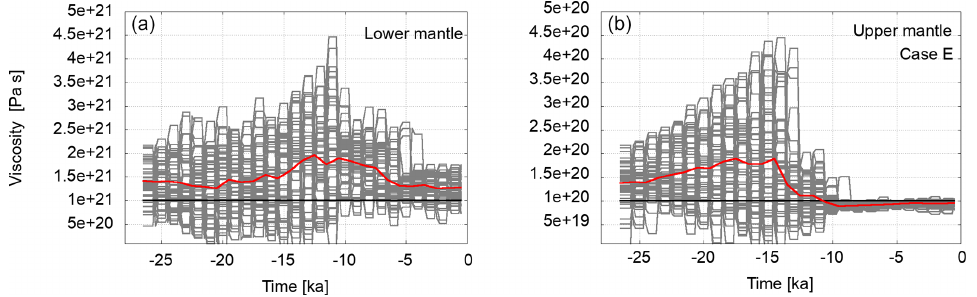
Figure 10. Variations in the viscosity in the course of the assimilation in the lower mantle (a) and the upper mantle (b) for scenario three (test Case E) in grey. The flat segments represent the viscosity values of an ensemble member during the forecast phase. When observations are available, a model state may be resampled and perturbed. This changes the viscosity values as shown. The horizontal black lines represent the viscosities of the reference experiment towards which the ensemble mean is expected to converge. The red lines are the weighted ensemble means. For the initial value, all members are weighted equally. Thereafter, they are weighted by the likelihood of the observations given the current member model state. Please note the changed y -axis range in this plot.